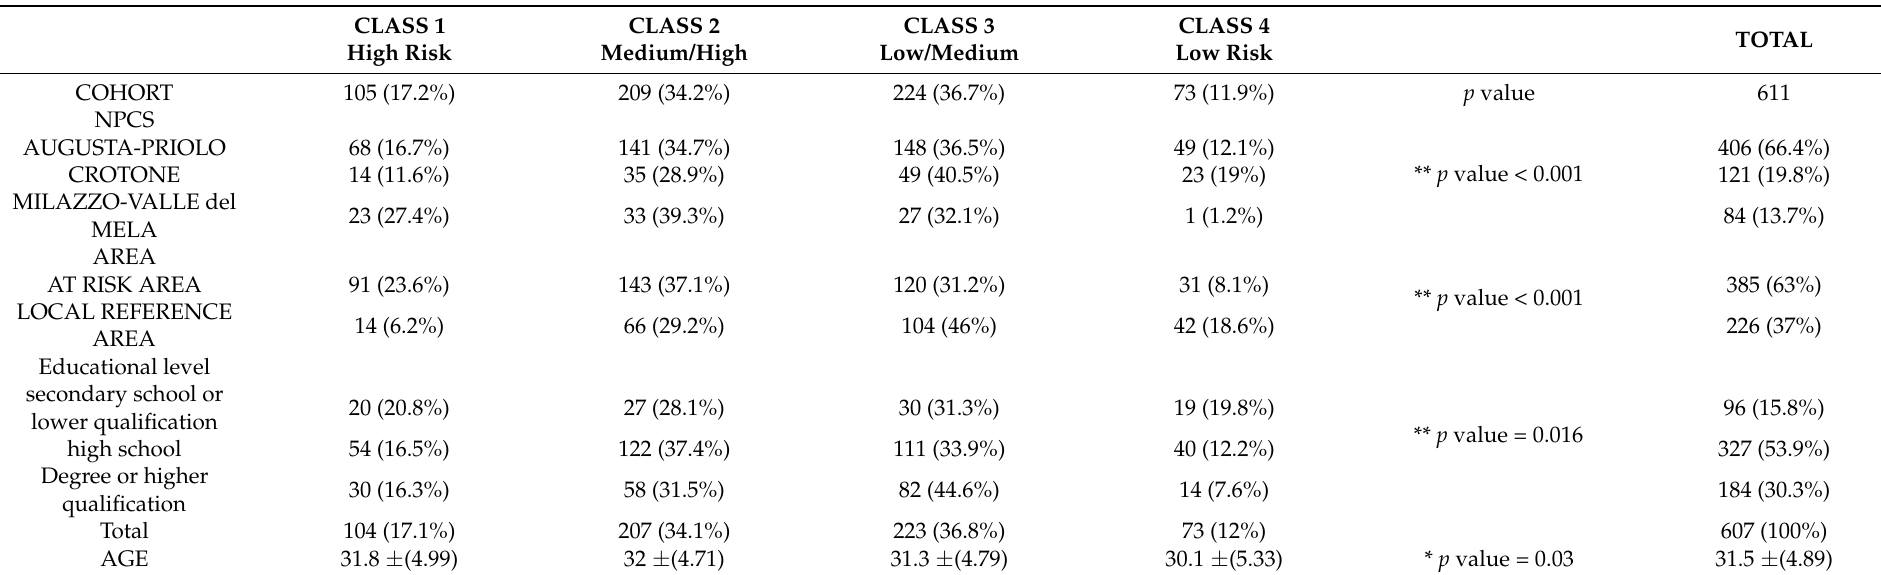
Table 5. Percentages or average mean and standard deviation of the national priority contaminated sites, area, educational level, and age, according to the classes from the latent class analysis